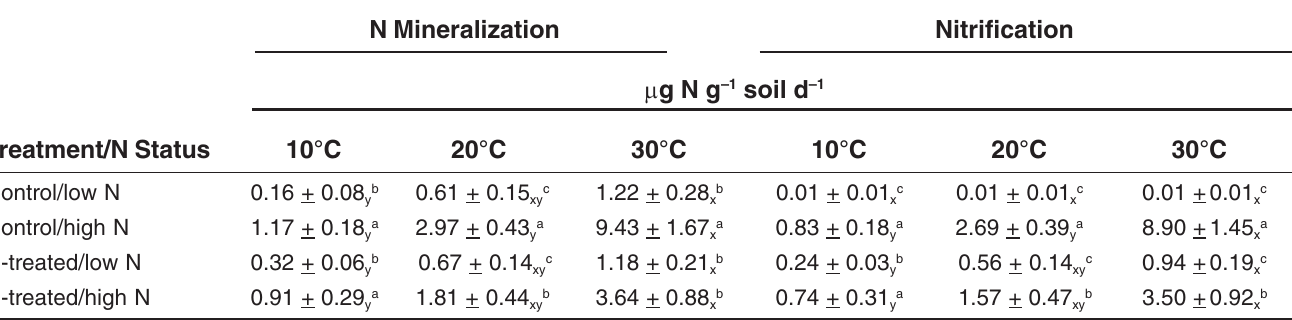
Means (+1 SE) for Net N Mineralization and Nitrification at Three Incubation Temperatures for Low N Processing and High N Processing Plots Within Control and N-Treated Watersheds of Fernow Experimental Forest, West Virginia* N Mineralization